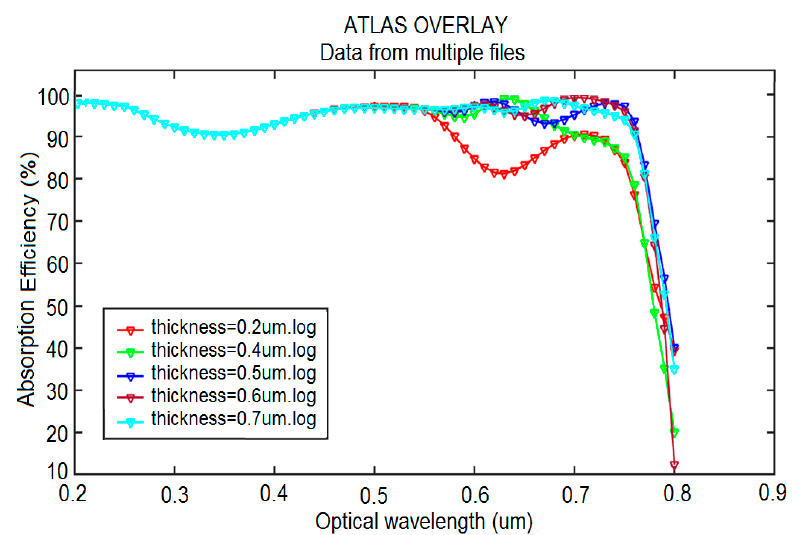
Figure 6. Effect of perovskite layer thickness variation on the photon absorption in the inverted planar PSC.